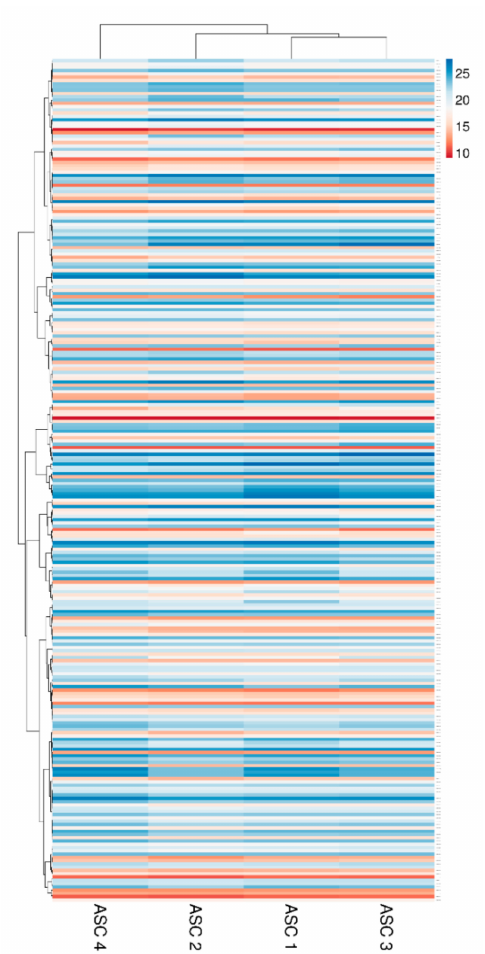
Figure 5. Heat map of EV-miRNAs across all samples. Heat map of hierarchical clustering analysis of the normalized C RT values of detected miRNAs in ASC-EVs. Rows are centered. The sample clustering tree is shown at the top. The color scale shown in the map illustrates the absolute expression levels of factors across all samples: red shades = high expression levels (low C RT values) and blue shades = lower expression levels (high C RT